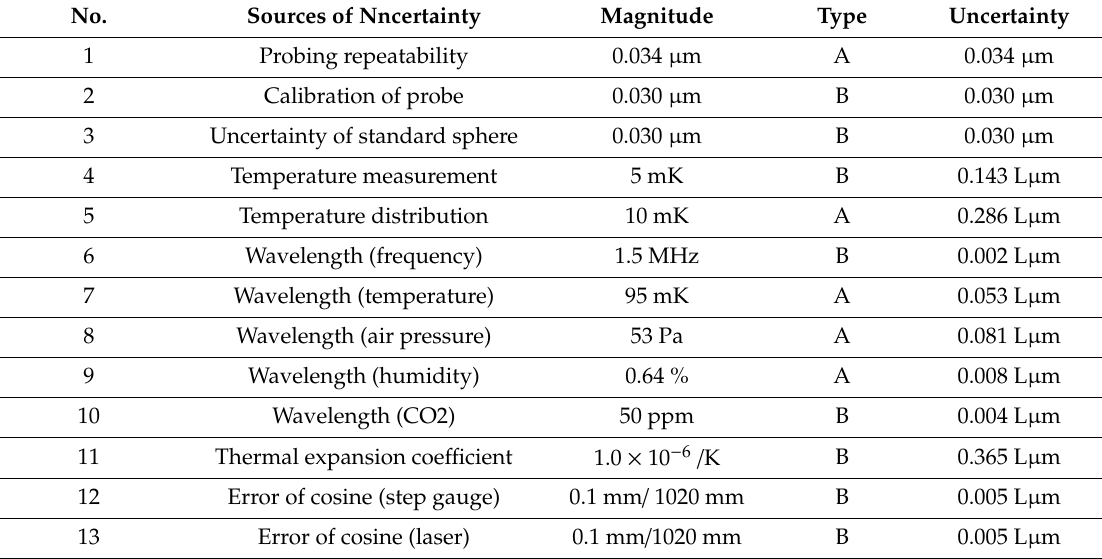
Table 2. Uncertainty budget in step gauge